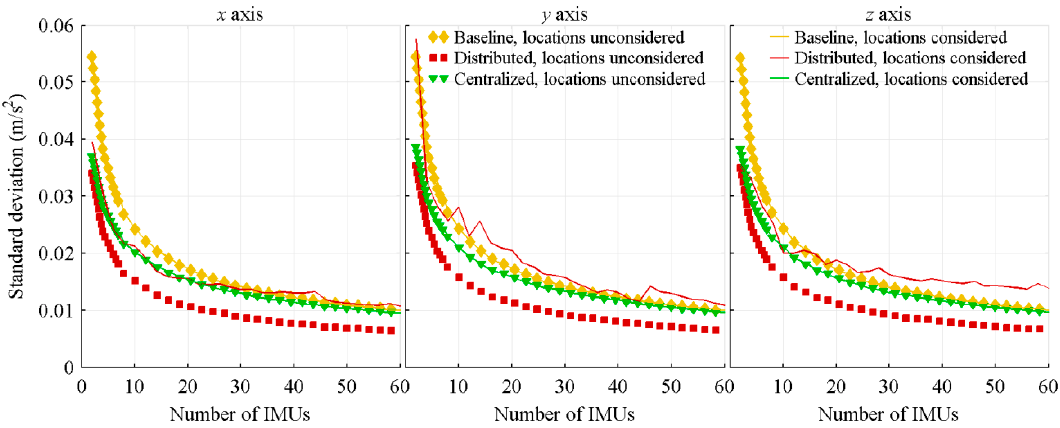
Figure 4. Standard deviation of the acceleration estimation errors, with respect to the number of IMUs.